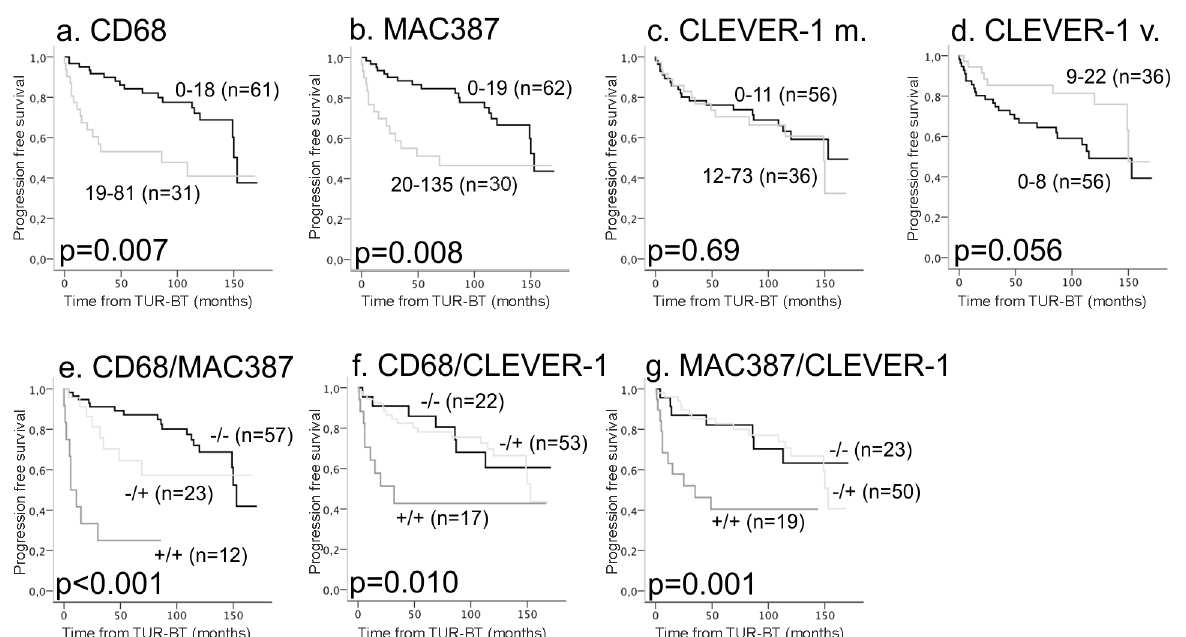
Fig 3. Kaplan-Meier estimates for progression in the TUR-BT population. The effect of CD68 + macrophages, MAC387 + macrophages, and CLEVER-1/ Stabilin-1 + macrophages/vessels on progression in the TUR-BT population (a-d). Patients were divided into groups according to the expression of two macrophage markers, and associations with progression were determined